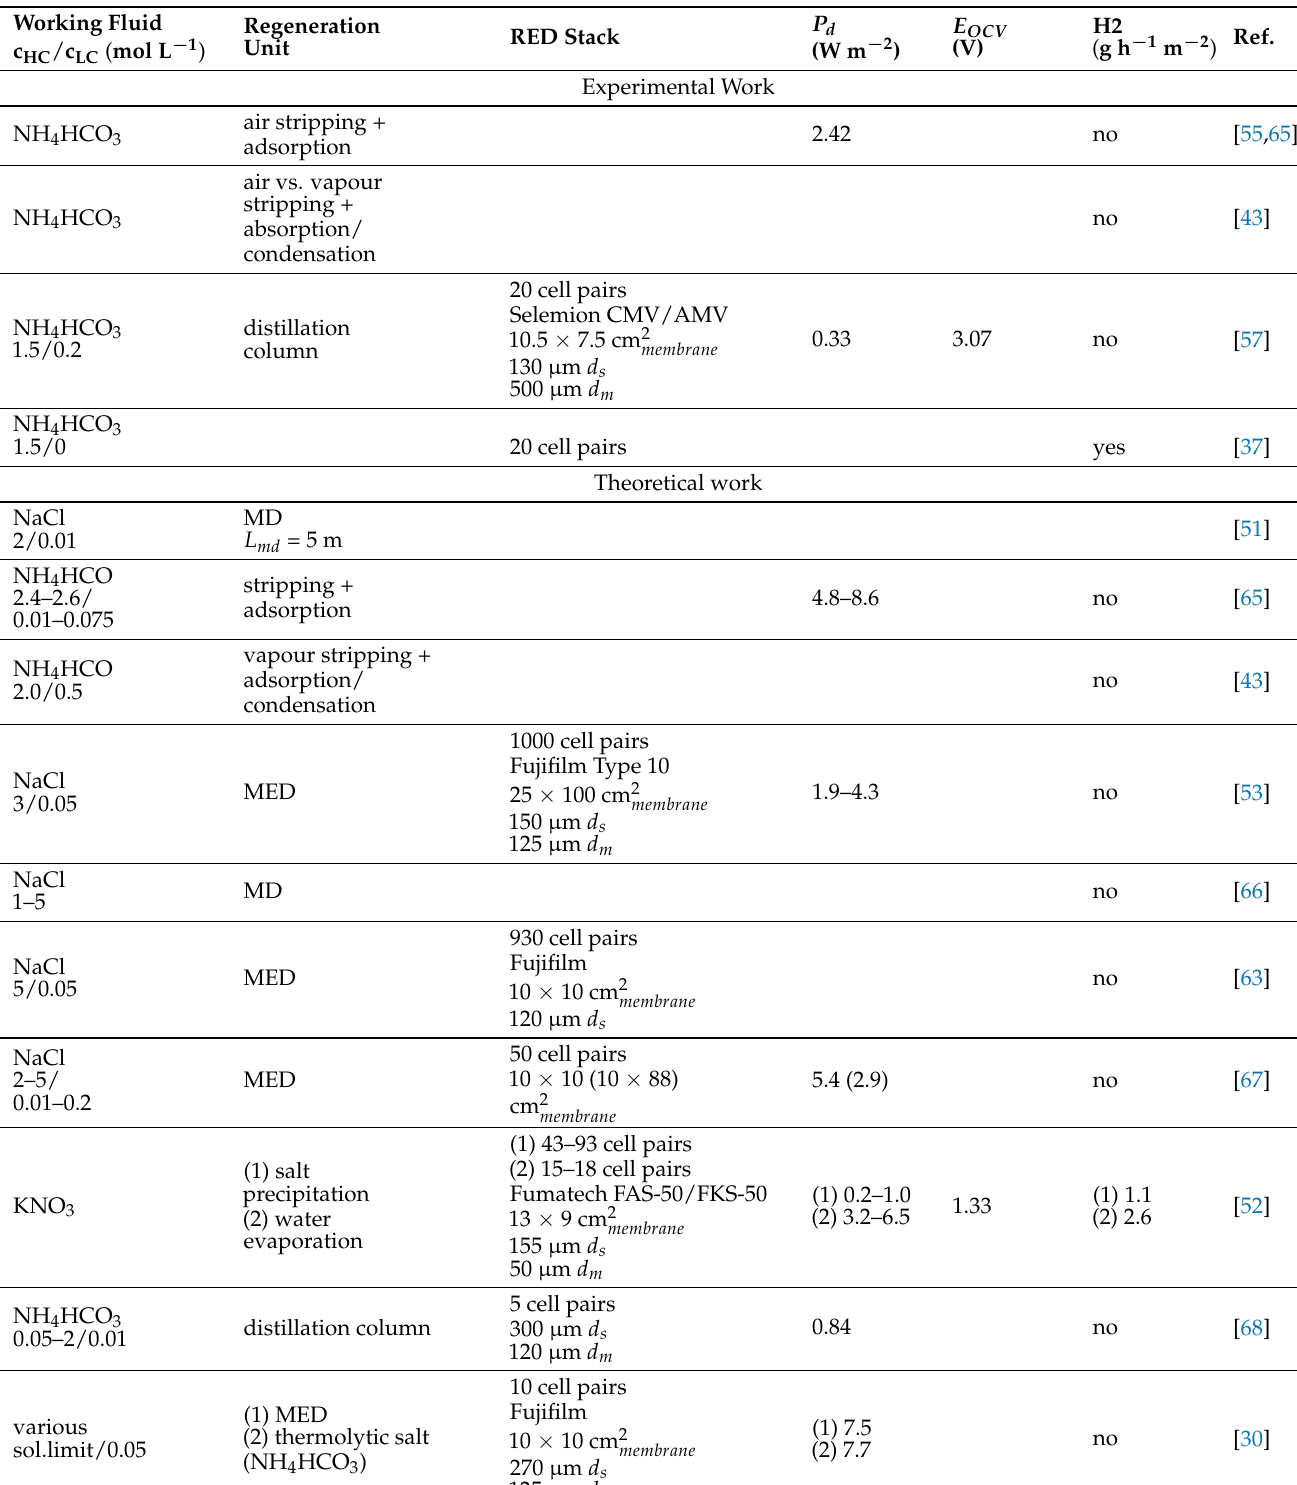
Table 1. Overview of studies on RED Heat